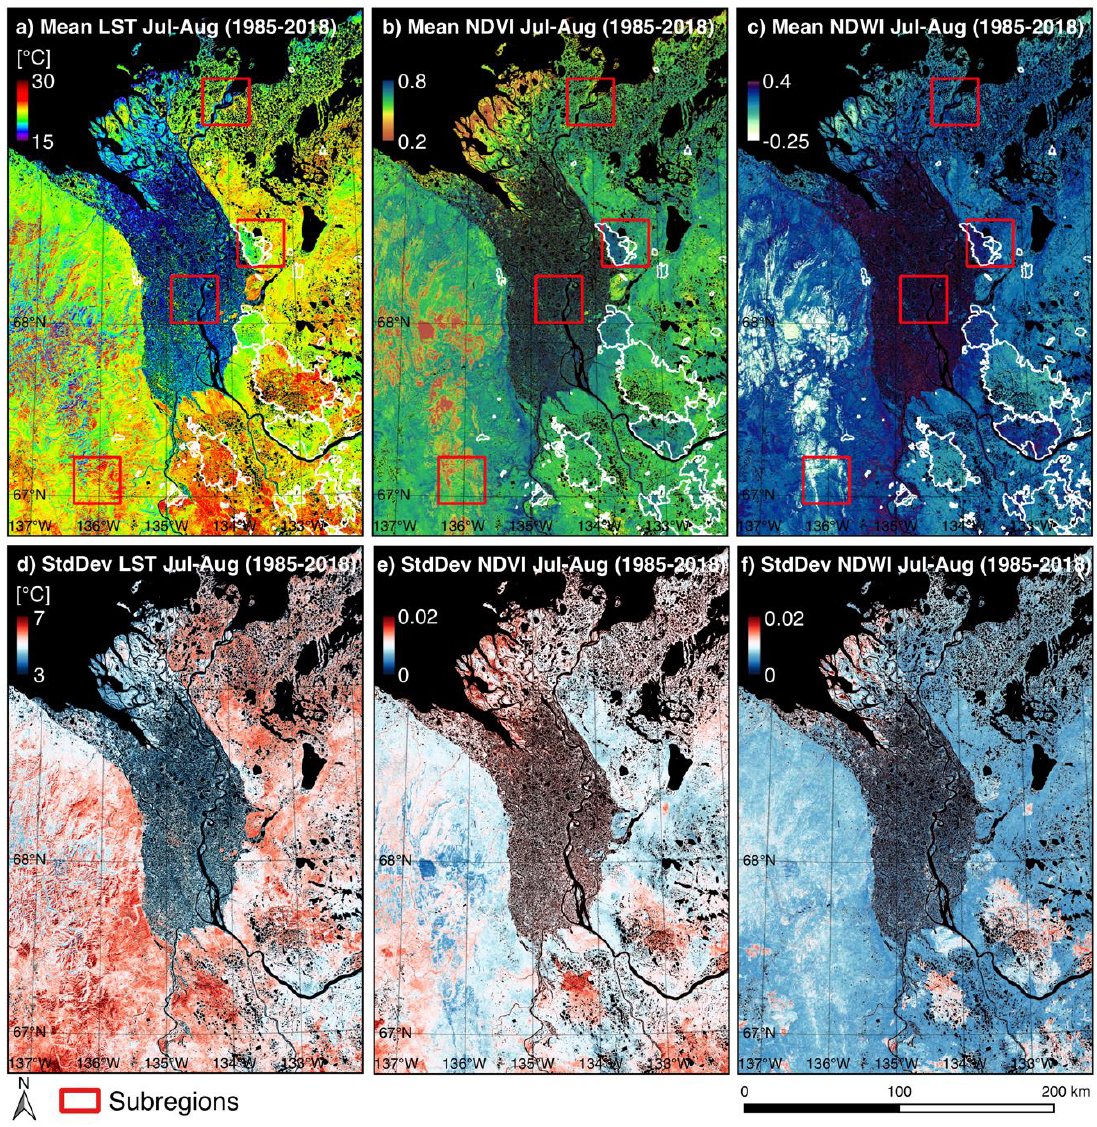
Figure 4. Pixel based means ( a – c ) and standard deviations ( d – f ) of summer (i.e., July, August) Land Surface Temperature (LST), Normalized Di ff erence Vegetation Index (NDVI), and Normalized Di ff erence Water Index (NDWI) for the period from 1985 to 2018. The red rectangular boxes highlight the subregions, and the white polygons indicate the extent of former